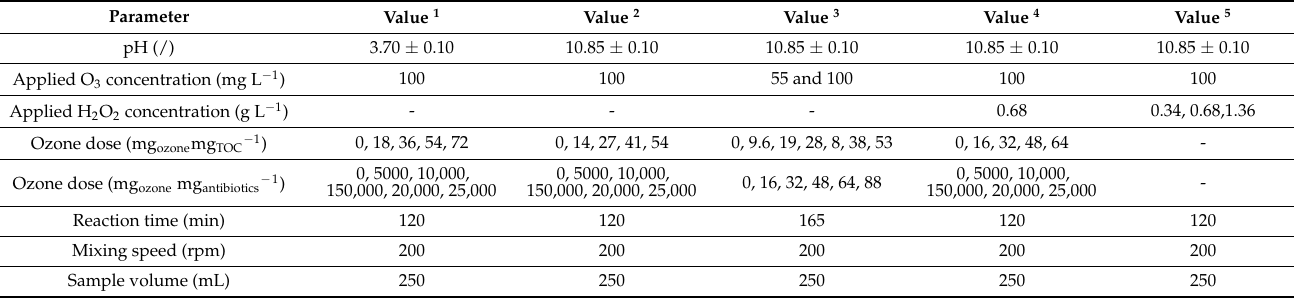
Table 1. Experimental